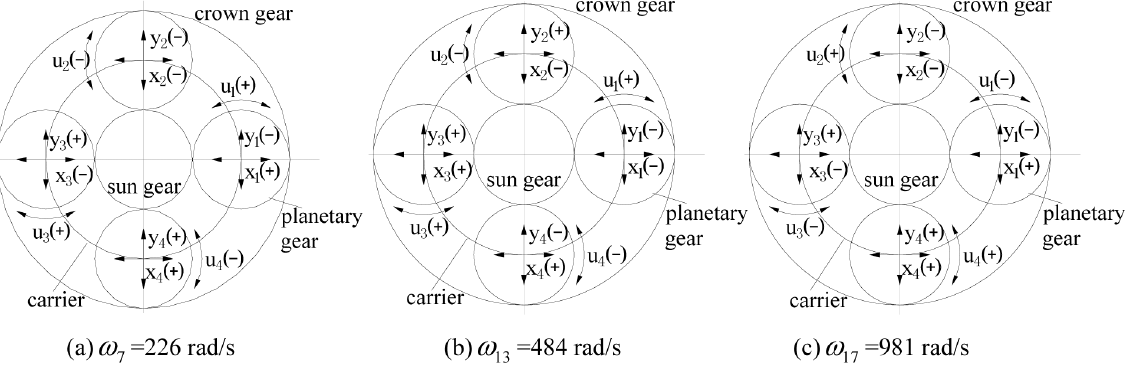
Fig. 6. Planetary gear modes ( N = 4).